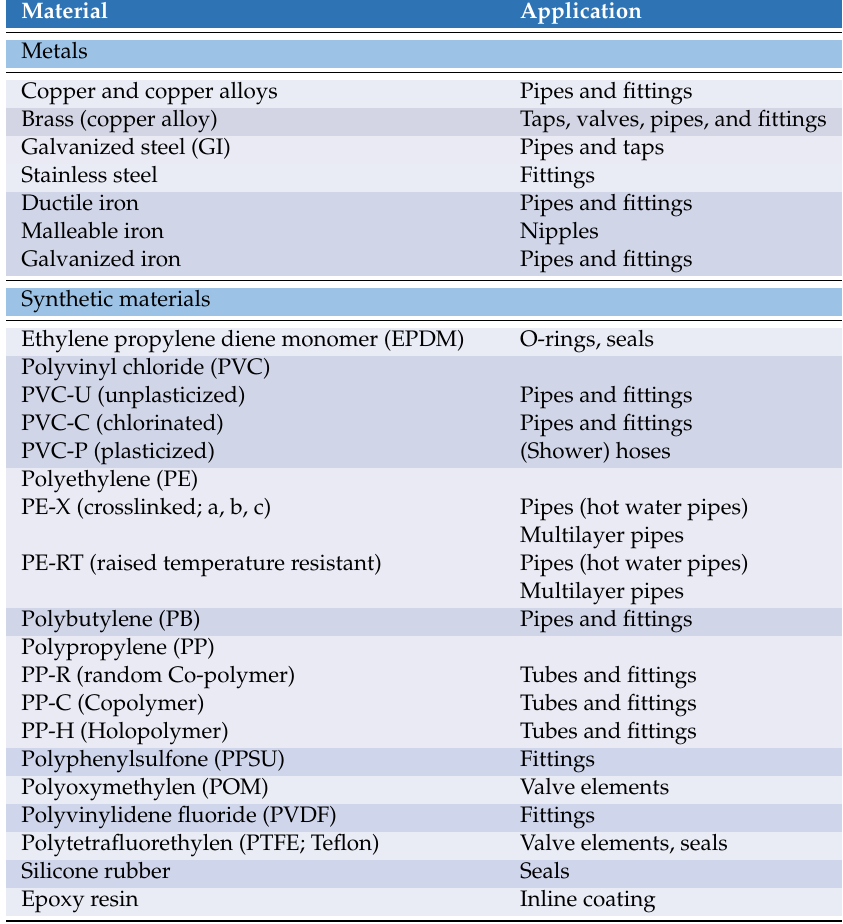
Table 1. Materials used in building plumbing systems and their